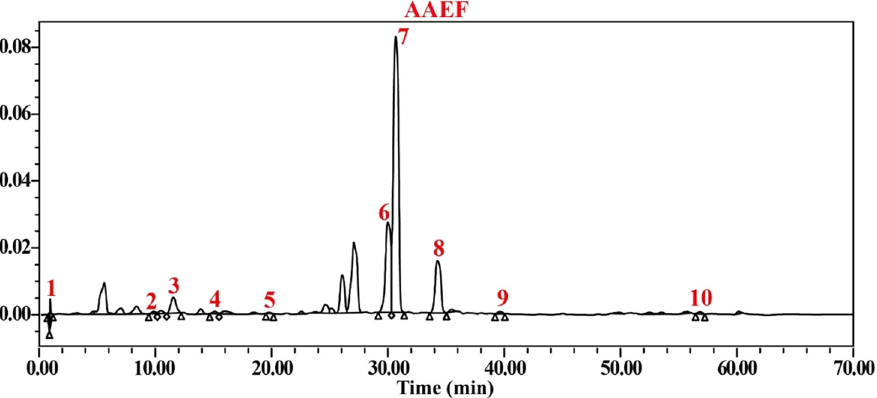
Figure 4: HPLC chromatogram of A. alpinum ethyl acetate fraction ( AAEF ) . Peaks showing similar retention time to 1: gallic acid ( 0.970 min ) , 2: ca ff eic acid ( 9.888 min ) , 3: chlorogenic acid ( 11.550 min ) , 4: epicatechin ( 15.113 min ) , 5: ferulic acid ( 19.763 min ) , 6: luteolin ( 29.988 min ) , 7: rutin ( 30.660 min ) , 8: apigenin - 7 - o - glucoside ( 34.263 min ) , 9: naringenin ( 39.615 min ) and 10: chrysin ( 56.784 min )